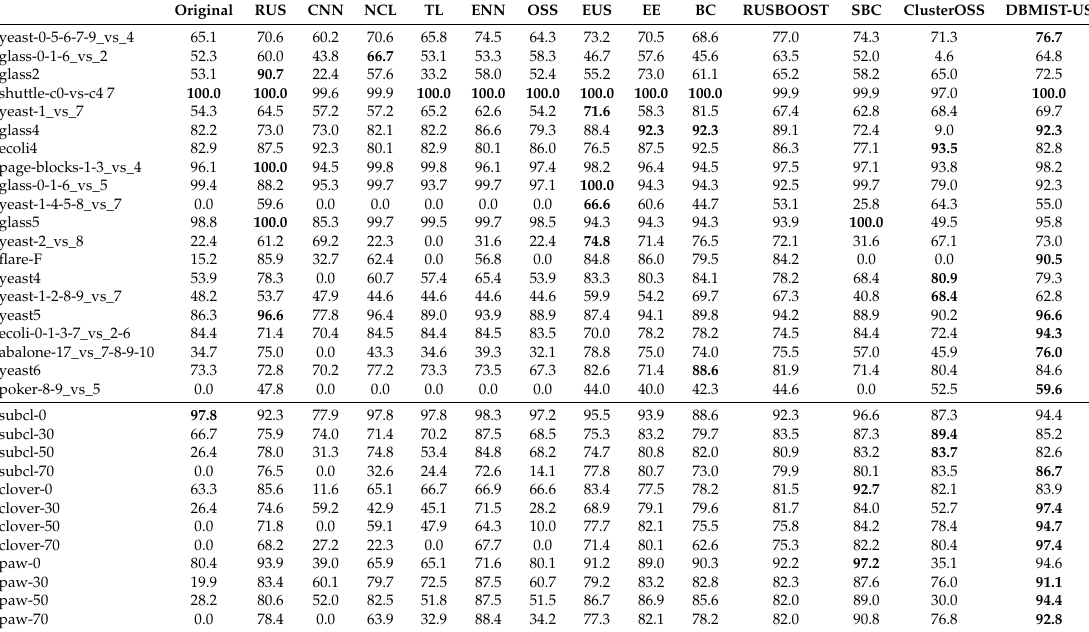
Table A2. Geometric mean results obtained with J48.